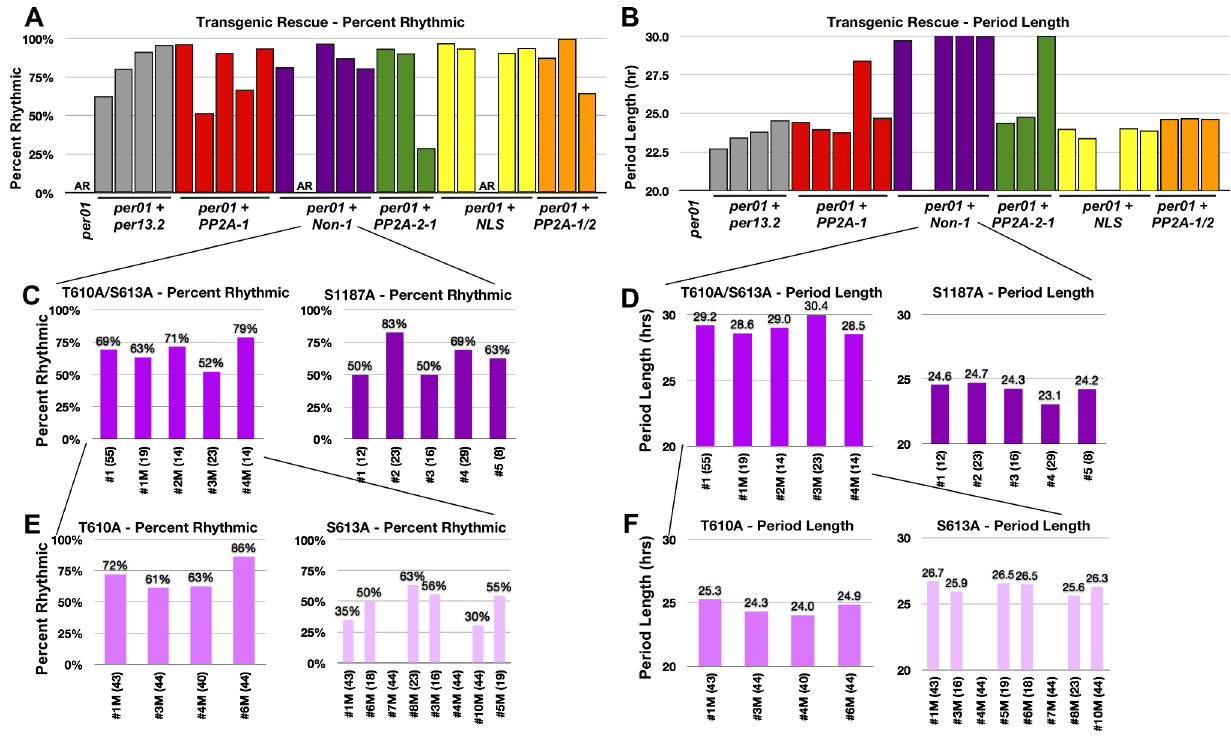
Figure 3. Residues T610 and S613 cooperate to control period length. ( A and B ). Graphs depicting percent rhythmic (A) and period length (B) of various transgenic lines containing groups of phospho-mutations highlighted in Figure 1. Non-1 transgenic flies, containing only three mutant residues, exhibit a period length to , 29–30 hours (purple bars in B). The long period phenotype exhibited by one individual line from PP2A-1 and PP2A-2 (panel B, Table 1) are probably not meaningful since rhythmicity of these lines is low and additional transgenic lines of the same construct exhibit normal PER function. While not tested, perhaps PER protein levels in these lines are lower than the others. ( C and D ) Graphs depicting percent rhythmic (C) and period length (D) of transgenic lines harboring either the T610A/S613A mutations or the single S1187A mutation. The T610A/S613A double mutant transgene retains the long period phenotype (D). ( E and F ) Graphs depicting percent rhythmic (E) and period length (F) of transgenic lines harboring either the single T610A or single S613A mutation. Note, neither single mutant displays a period length as long as the double mutant suggesting they function cooperatively to maintain wild type period length. In all graphs, period lengths are listed above each bar and values in parentheses indicate the number of flies analyzed. Variation in strength of rescue is attributed to differences in genomic insertion sites; data from all lines are shown. Raw data is summarized in Table 1. Only male flies were analyzed in these experiments.